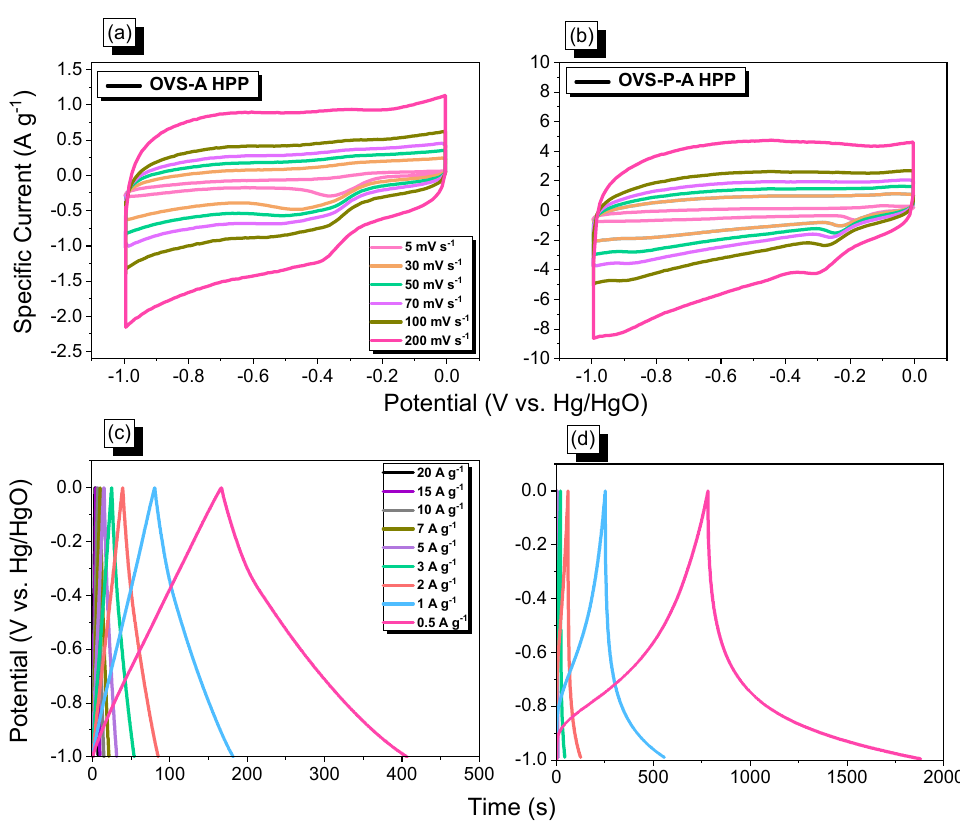
Figure 7. ( a , b ) CV and ( c , d ) G curves, of ( a , c ) OVS-A HPP and ( b , d ) OVS-P-A HPP. The specific capacitances of OVS-A HPP and OVS-P-A HPP, calculated from GCD curves, were 120 F g − 1 (calculated by using Equation (S1)) and 177 F g –1 (calculated by using